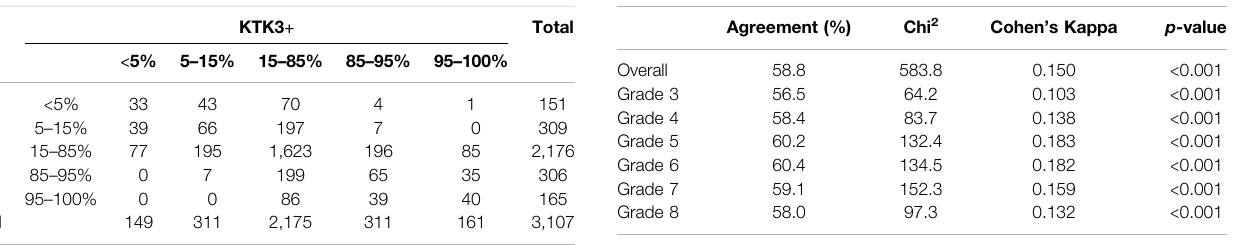
TABLE 4 | Agreement scores and Cohen ’ s Kappa between the KTK3+ and the